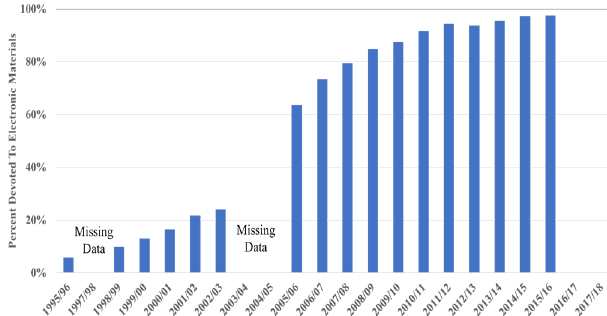
Figure 1 Transition Data Print to Digital: Percent of Collection Budget Devoted to Electronic Materials